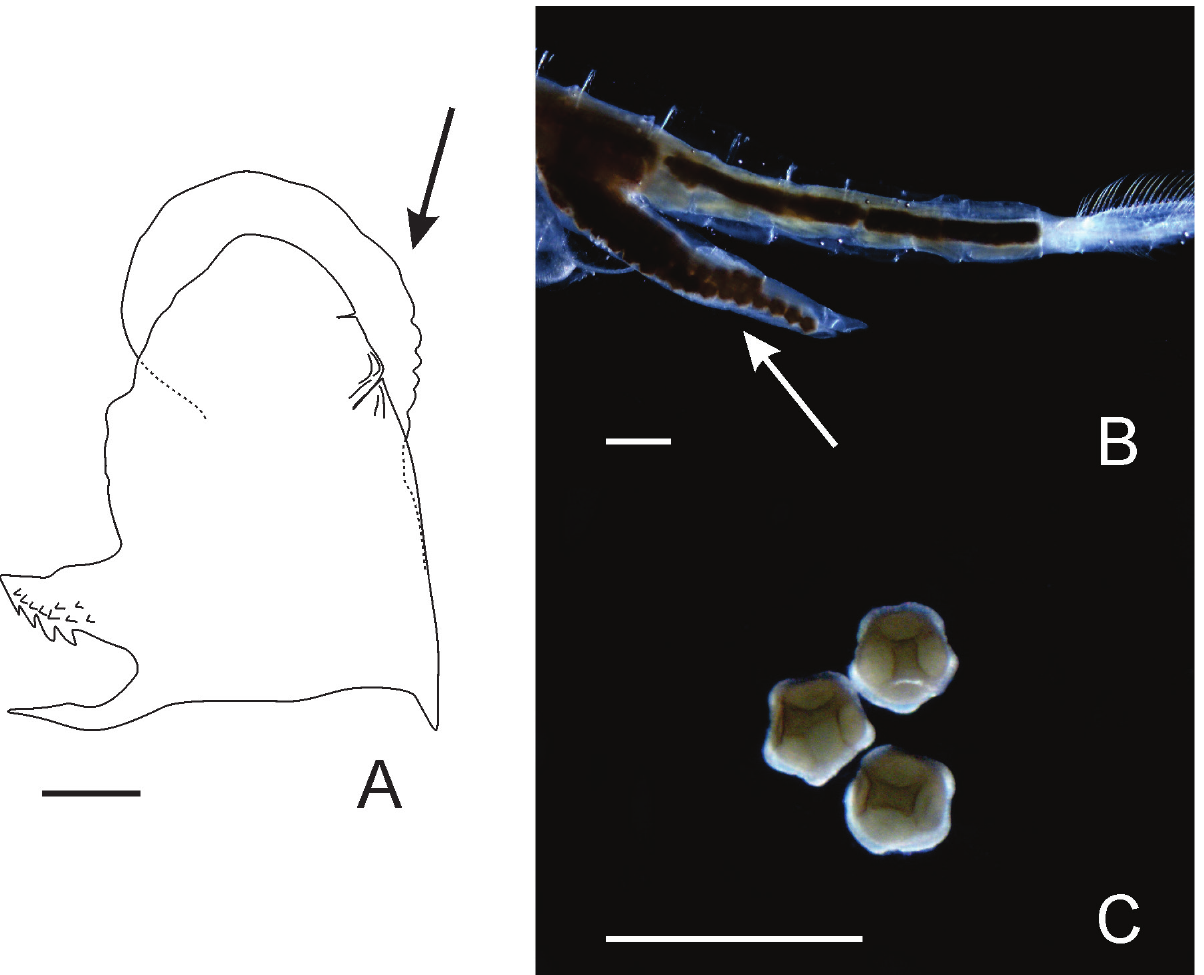
Figure 6. Dendrocephalus brasiliensis Pesta, 1971 from Porto Real do Colégio, Alagoas, Brazil (CARCINO 104). A) non-everted gonopod lateral view; B) brood pouch; C) polyhedral resting eggs with rounded ridges. Scale bars = 0.2 mm. The arrow indicates the nude appearance, with a small groove at the tip of the distal end of the retracted